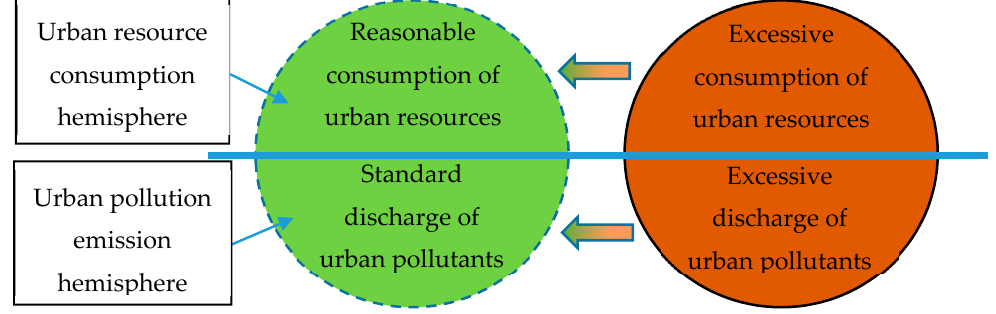
Figure 4. Matching of the Urban Ecological Sustainable Hemispheres.